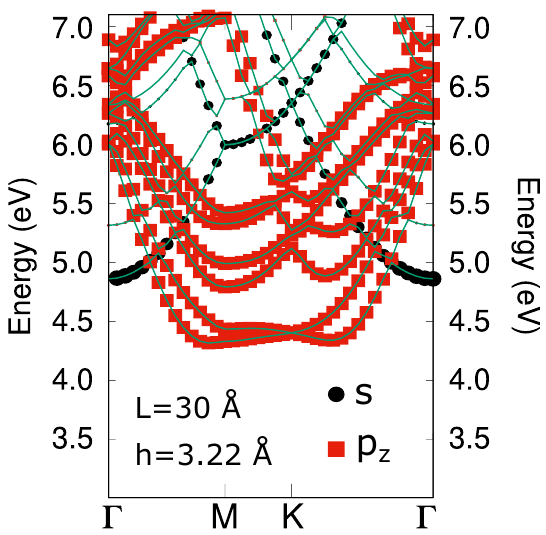
Figure 12: Orbital momentum component of the conduction bands of the BN(1,2) bilayer (fat bands).